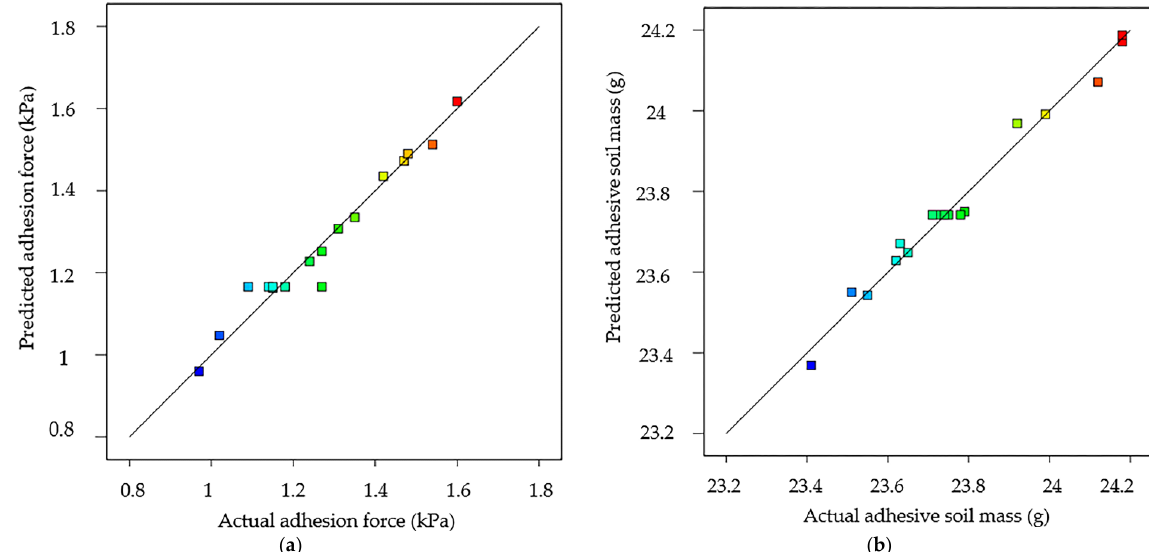
Figure 3. Predicted vs. actual values of the response indicators. ( a ) Predicted vs. actual values of adhesion force; ( b ) predicted vs. actual values of adhesive soil mass.